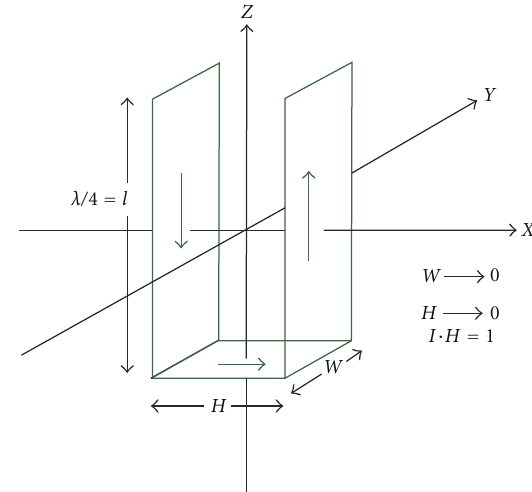
Figure 3: The geometry of a current source which radiates power isotropically. We put L = λ/ 4 and take the limit H → 0 and W → 0, keeping I · H = 1, where I is the maximum value of the current. hence, we have for the polar components A θ , A ϕ